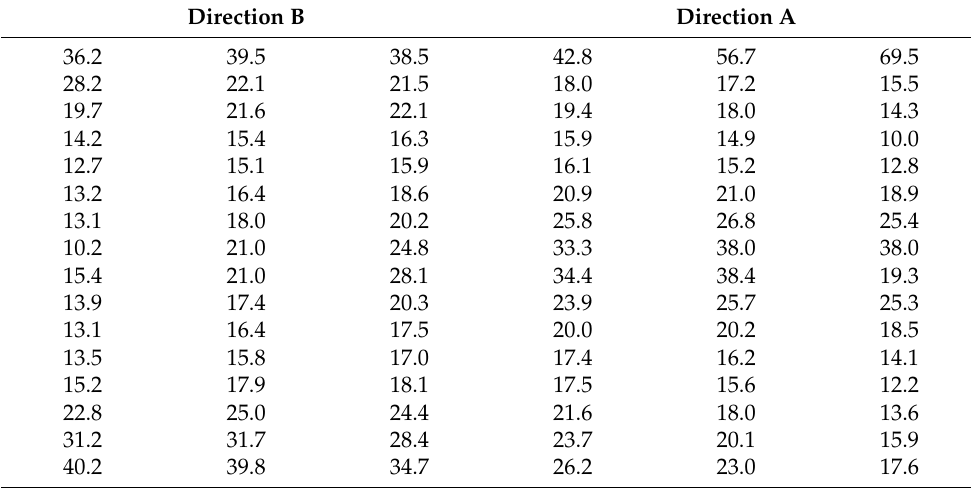
Table 3. Measurements on the road surface 1.5 m.